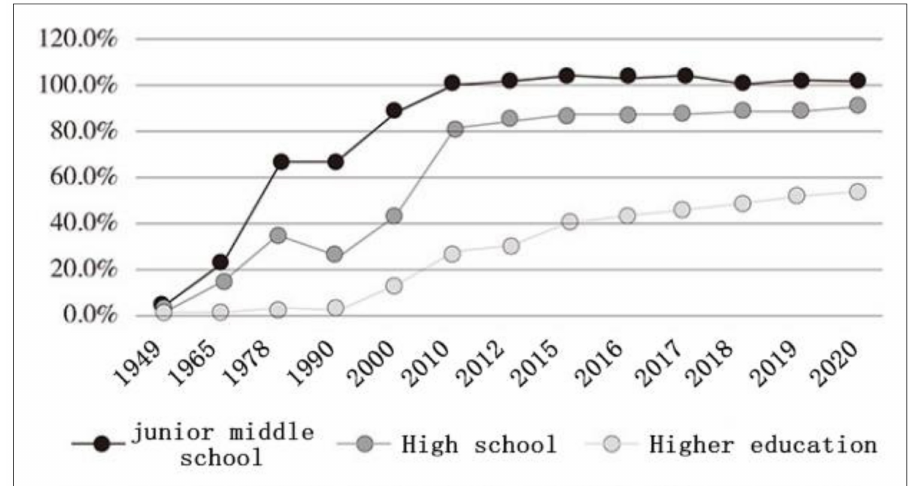
Figure 6. Gross enrollment rate of junior middle school, senior high school, and higher education in China from 1949 to